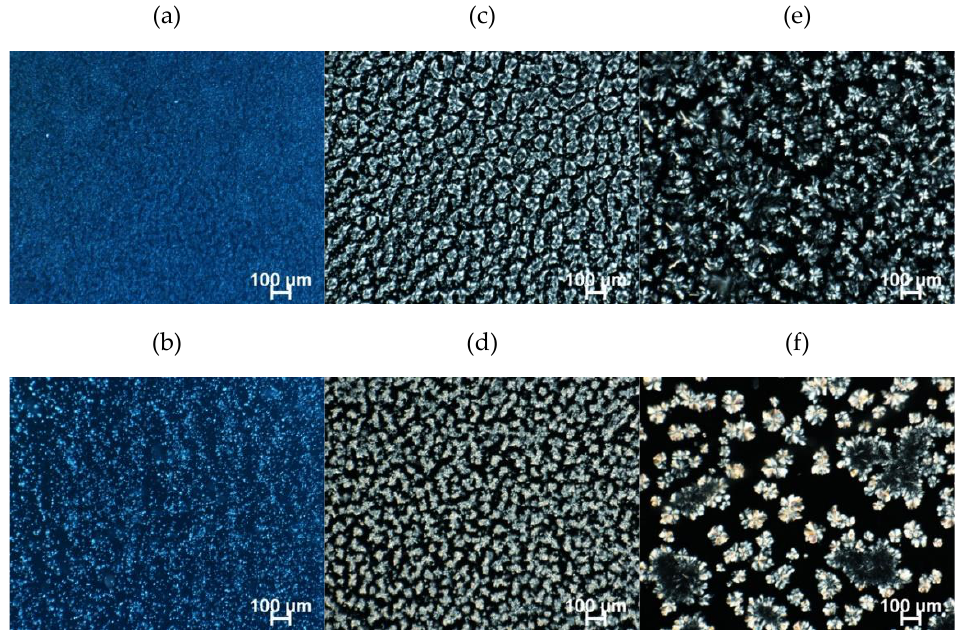
Figure 4. Polarized light microscopy of monocomponent oleogels with total oleogelator concentration of 6% ( w/w ). GMS0:100BEW at 5 °C ( a ); GMS0:100BEW at 25 °C ( b ); GMS0:100SHW at 5 °C ( c ); GMS0:100SHW at 25 °C ( d ); GMS100 at 5 °C ( e ), and GMS100 at 25 °C ( f ).